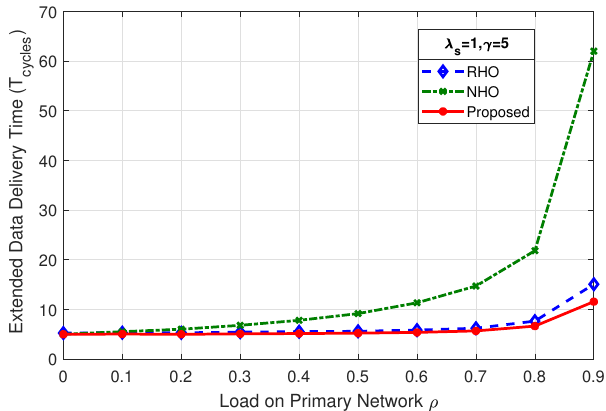
Figure 9. Comparison of mean EDDT for λ s = 1, γ =